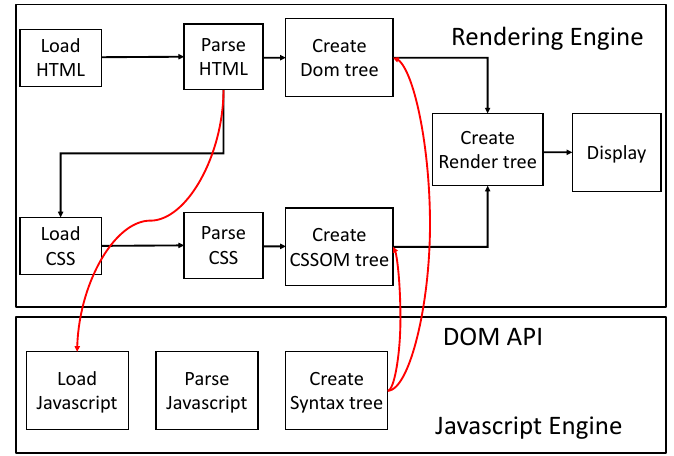
Figure 1. JavaScript working